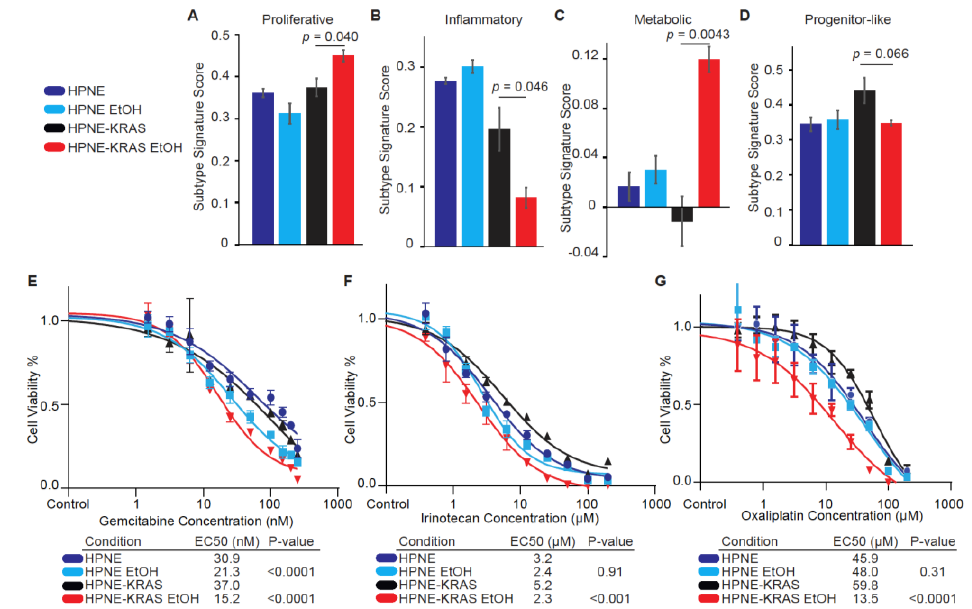
Figure 7. PDAC subtype signatures and chemotherapy sensitivity are associated with ethanol conditioning in mutant KRAS HPNE cells. ( A – D ) Proteomics expression data were mapped to PDAC subtype proteomics signatures. The top 60 variable proteins were selected and mapped to the PLS-DA model from Law et al. ROC curves were used to determine the cutoff scores for the Proliferative ( A ), Inflammatory ( B ), Metabolic ( C ), and Progenitor-like ( D ) subtypes. ( E – G ) Cells were treated with chemotherapeutic drugs commonly used in PDAC therapy. HPNE, HPNE EtOH, and HPNE-KRAS cells were plated at a density of 5000 cells per well, HPNE-KRAS EtOH were plated at a density of 1000 cells per well. Cells were treated with increasing doses of Gemcitabine ( E ), Irinotecan ( F ), or Oxaliplatin ( G ) for 3 days. Cell viability was assessed by CellTiter-Glo following drug exposure to assess cell viability. Relative luminescence was read on a plate reader and IC50 values were determined by GraphPad Prism. Mean ± SEM; n = 4.